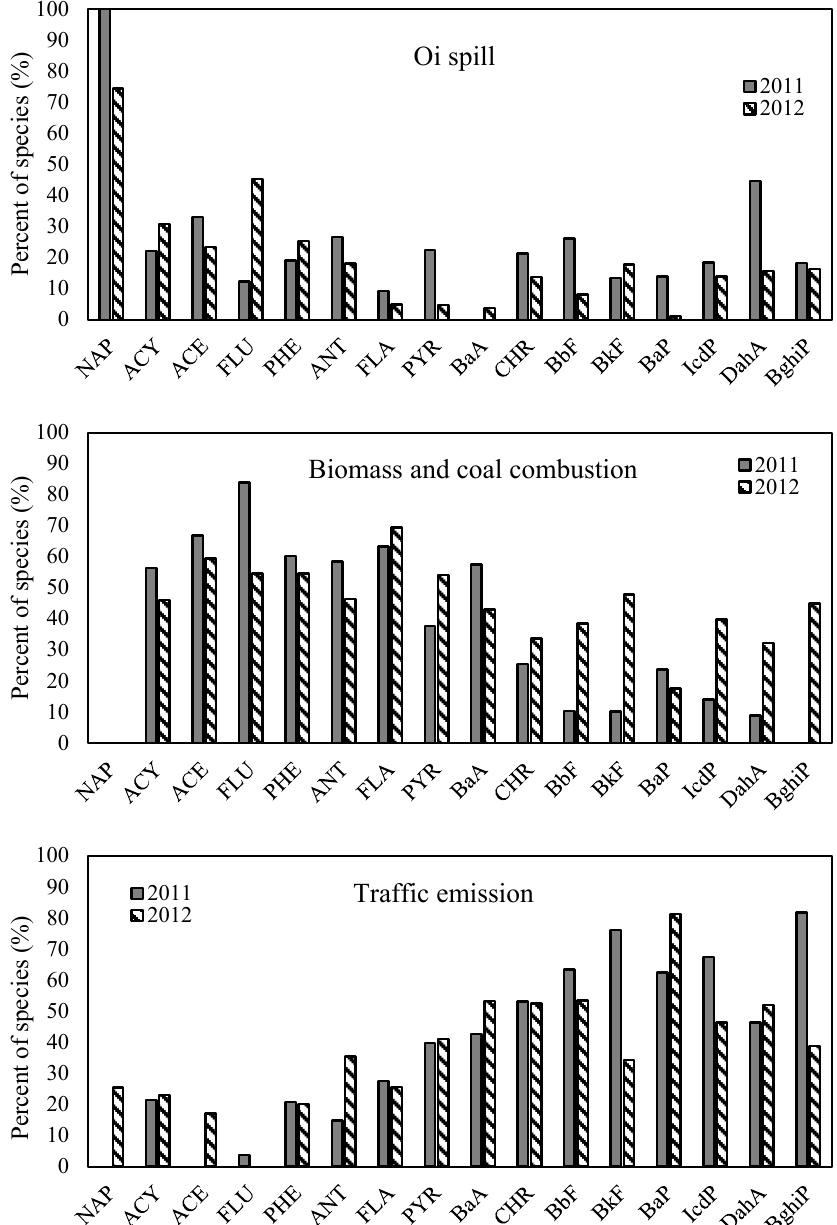
Figure 4. PAHs source profiles in 2011 and 2012 based on advanced PMF modeling result